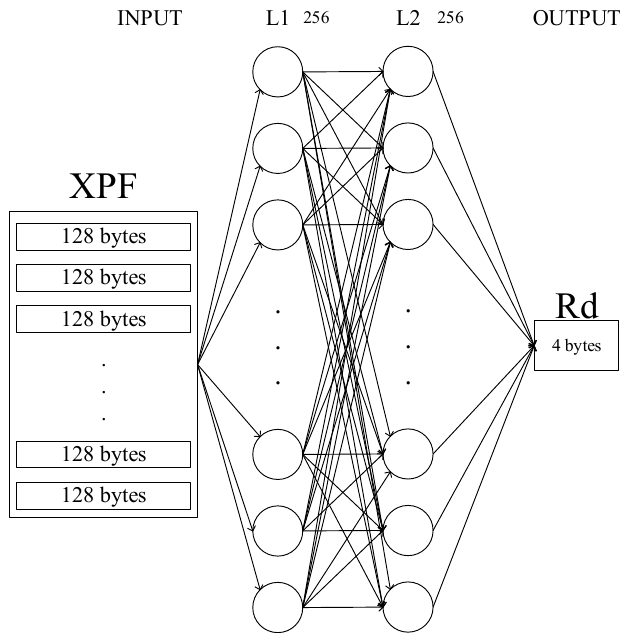
Figure 3. Model structure of the ANN used in the proposed system.